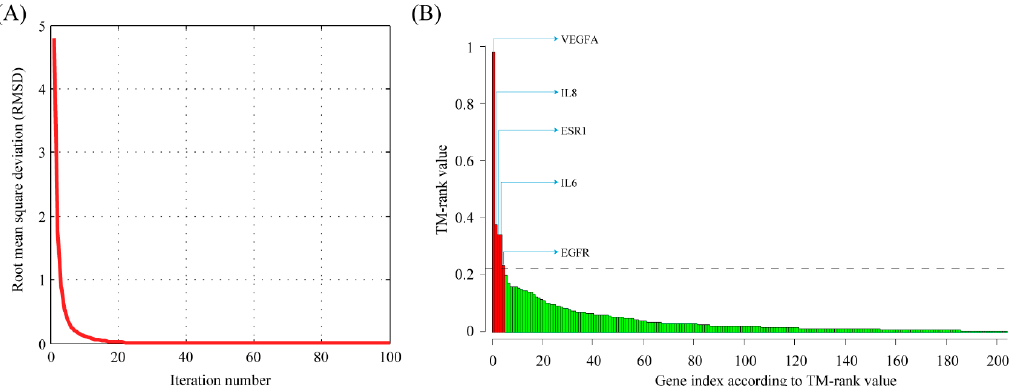
Figure 3. Prioritization of susceptibility genes for ectopic pregnancy by the TM-rank algorithm. ( A ) Convergence of the TM-rank algorithm. Convergence was confirmed by observing an exponential decrease in the RMSD (root mean square deviation) values during the sequential iteration; ( B ) Gene ranking by the TM-rank algorithm. Genes were sorted according to rank values in descending order. Top-ranked genes, which exceeded the mean plus two standard deviations, were labeled.